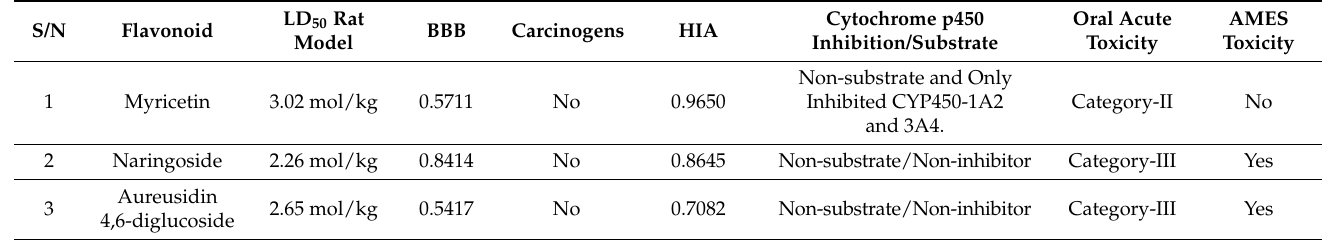
Table 3. Various ADMET profile in silico predicted values for the selected top three